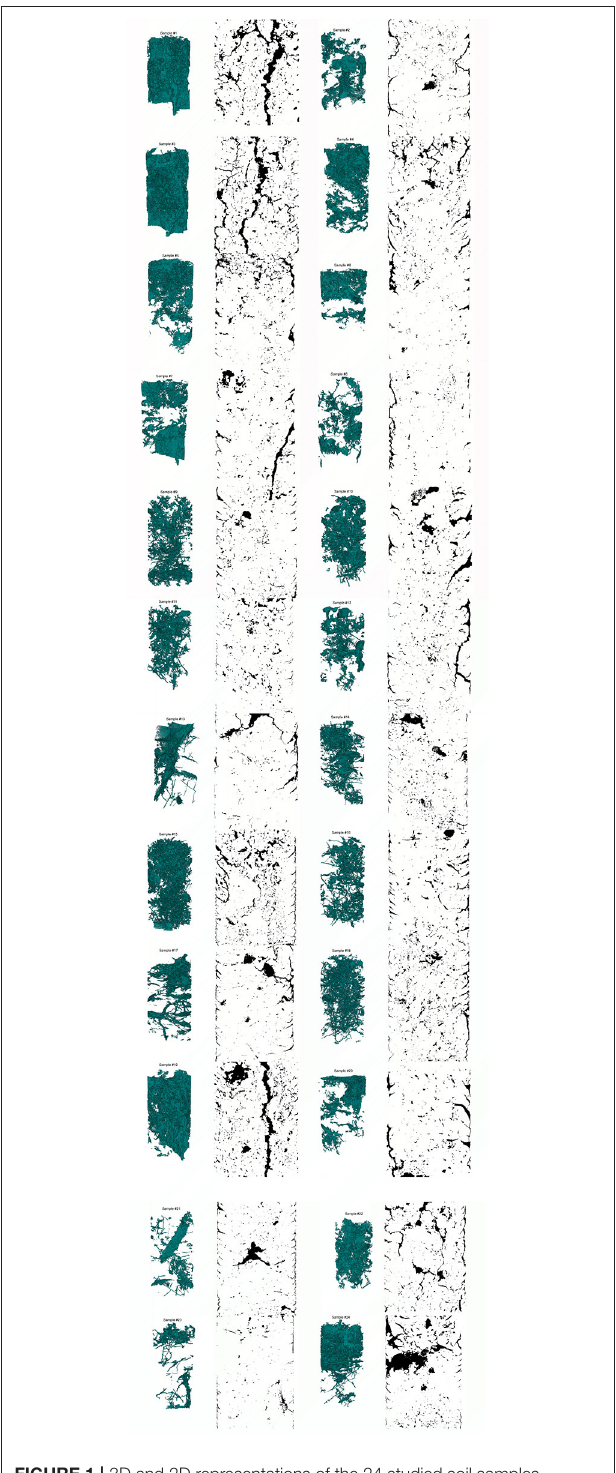
FIGURE 1 | 3D and 2D representations of the 24 studied soil samples.